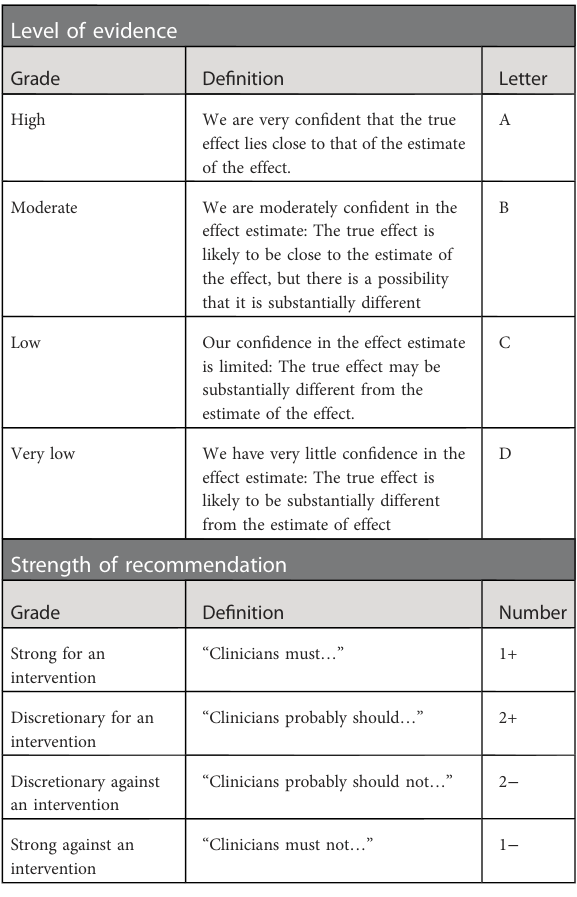
TABLE 1 Summary of level of evidence and strength of recommendation classi fi cation according to the GRADE